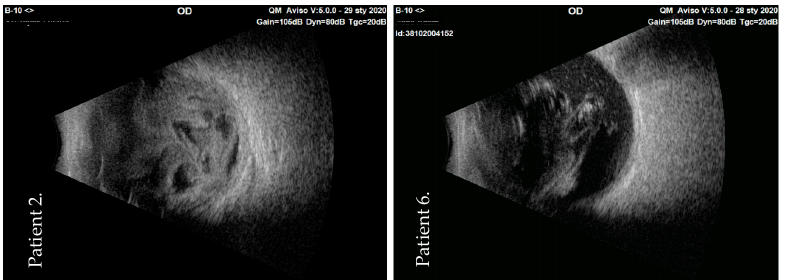
Figure 1. B-scan of ultrasonography images—acute inflammation of the vitreous in the initial examination of two patients (numbers 2 and 6) with post-injection endophthalmitis. OD: oculi dextri.